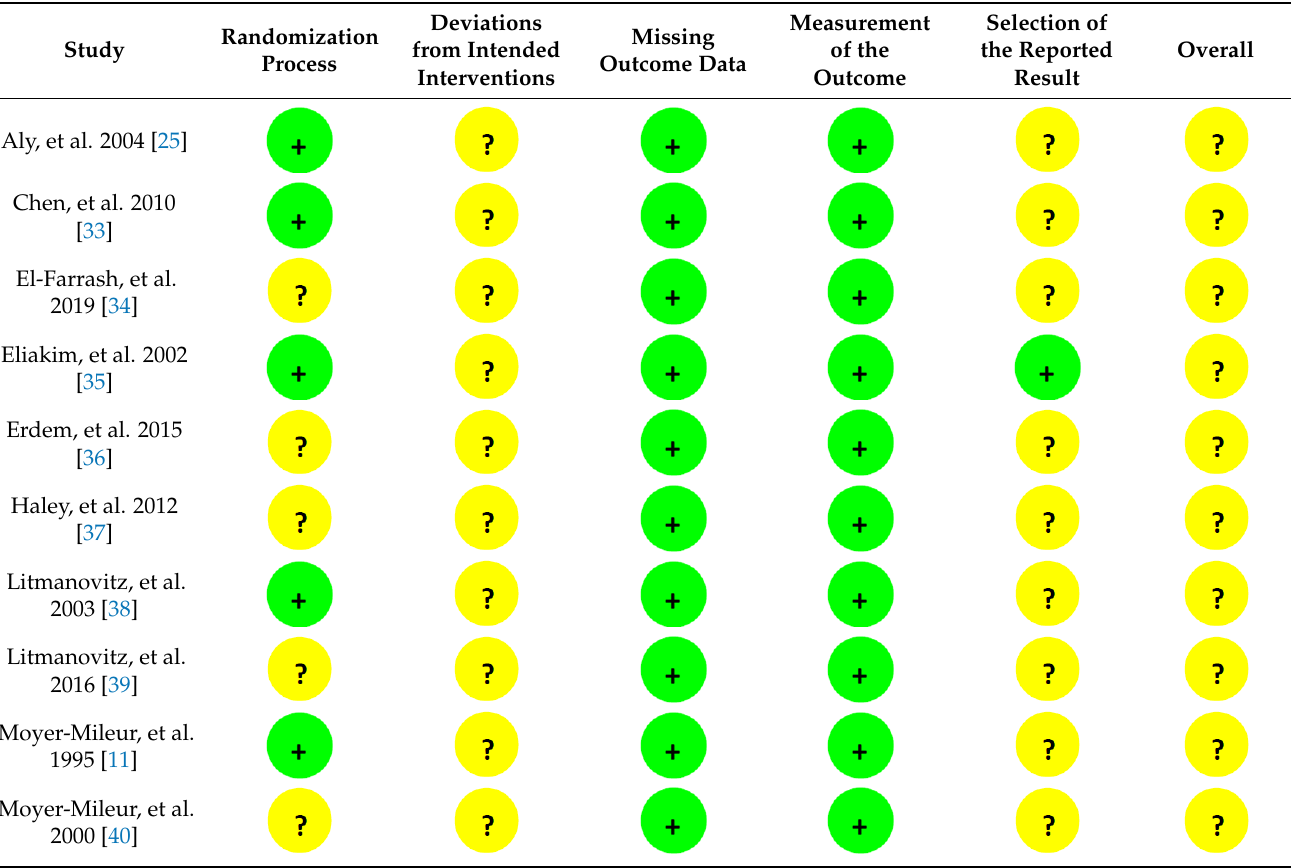
Table 4. Risk of bias assessed with the ROB-2 Cochrane